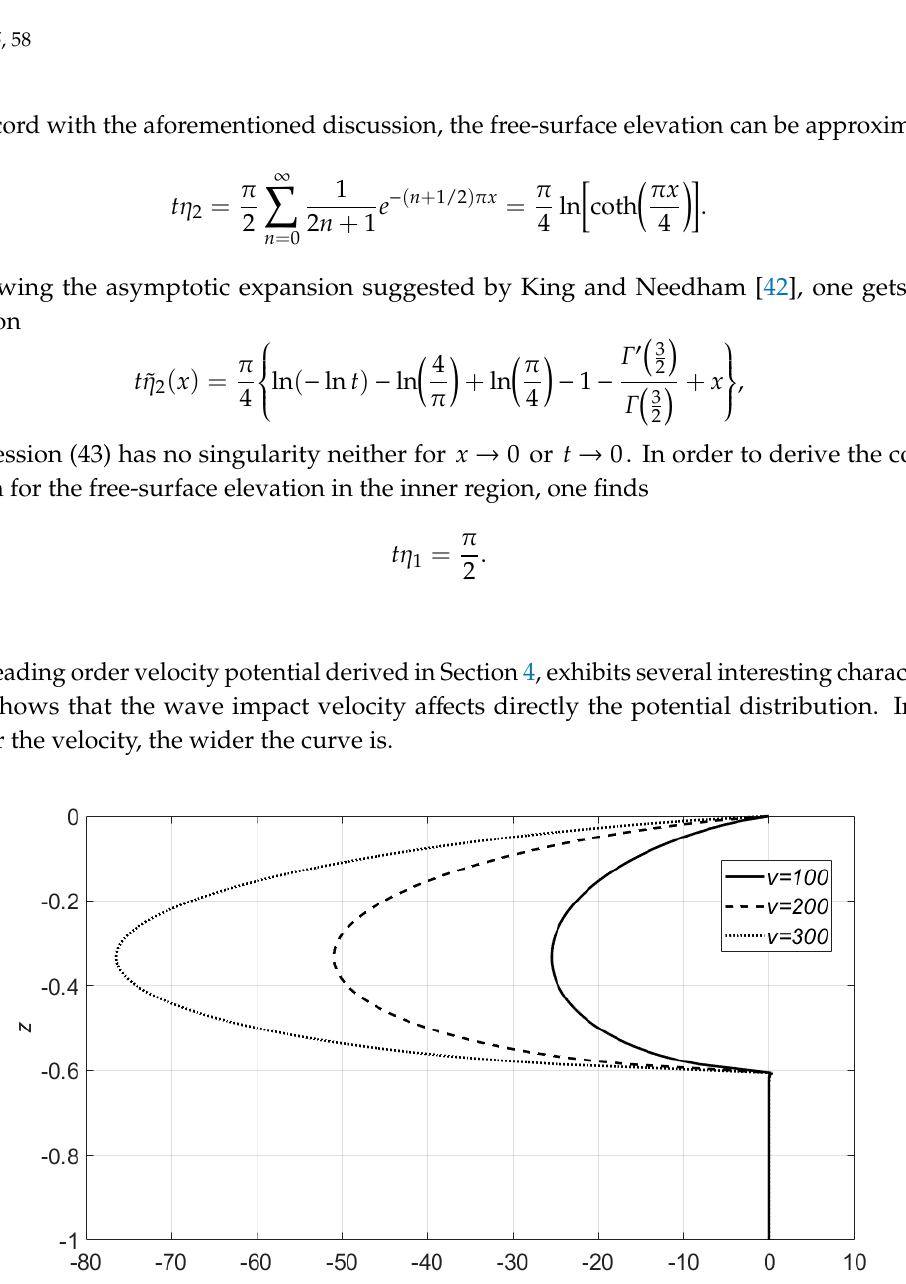
Figure 5. First order velocity potentials on the wall, (cid:2038) (cid:2869) (0, (cid:1878)) , for several air cavity positions and fixed wave impact velocity (cid:1874) = 300 at (cid:1872) = 0.01(cid:1871) . Figure 6 shows the velocity profiles connected with the test cases included in Figure 4. In the impacted region the velocity is constant, while in the air pocket region a rapid decrease close to zero is observed. Furthermore, an evident discontinuity occurs at (cid:1878) = −0.6 , i.e., at the point where the